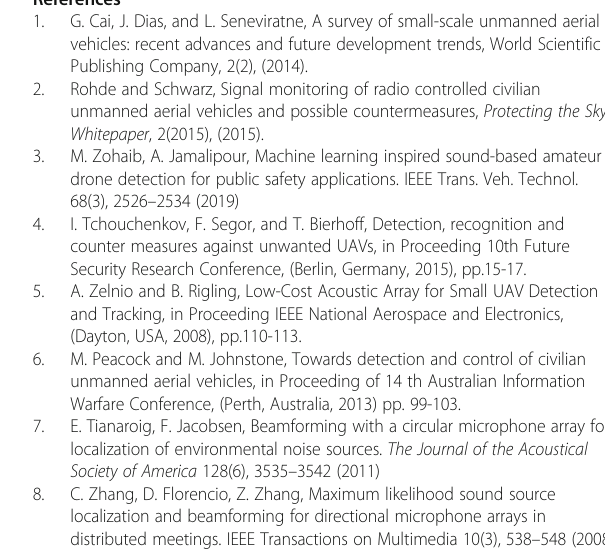
Table 5 Error performance from varying the direction of the interference Direction of interference (elevation, azimuth) = (18°,